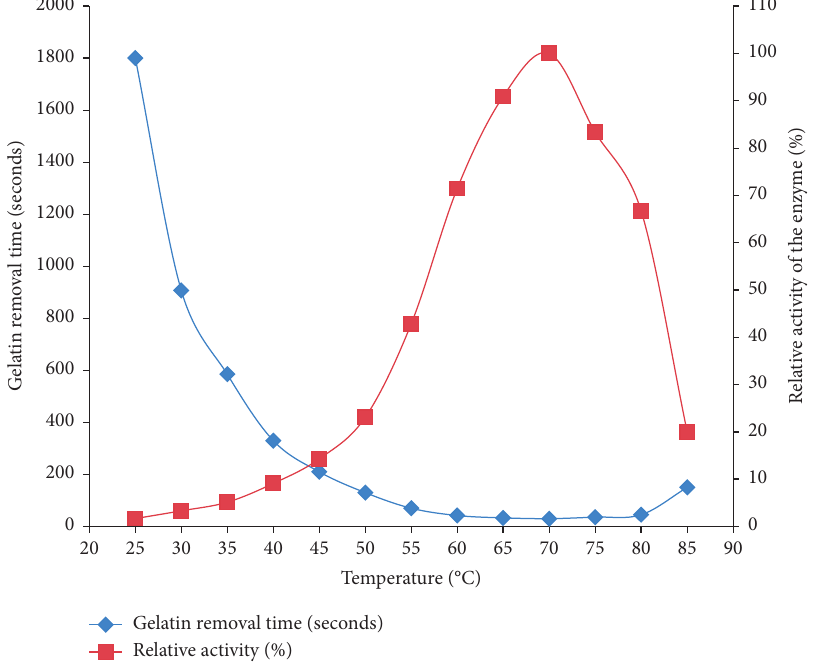
Figure 3: The effect of temperature on bromelain activity on removal of gelatin from X-ray film (reaction mix 20ml., i.e., 20ml enzyme or 144U) at a constant pH value of